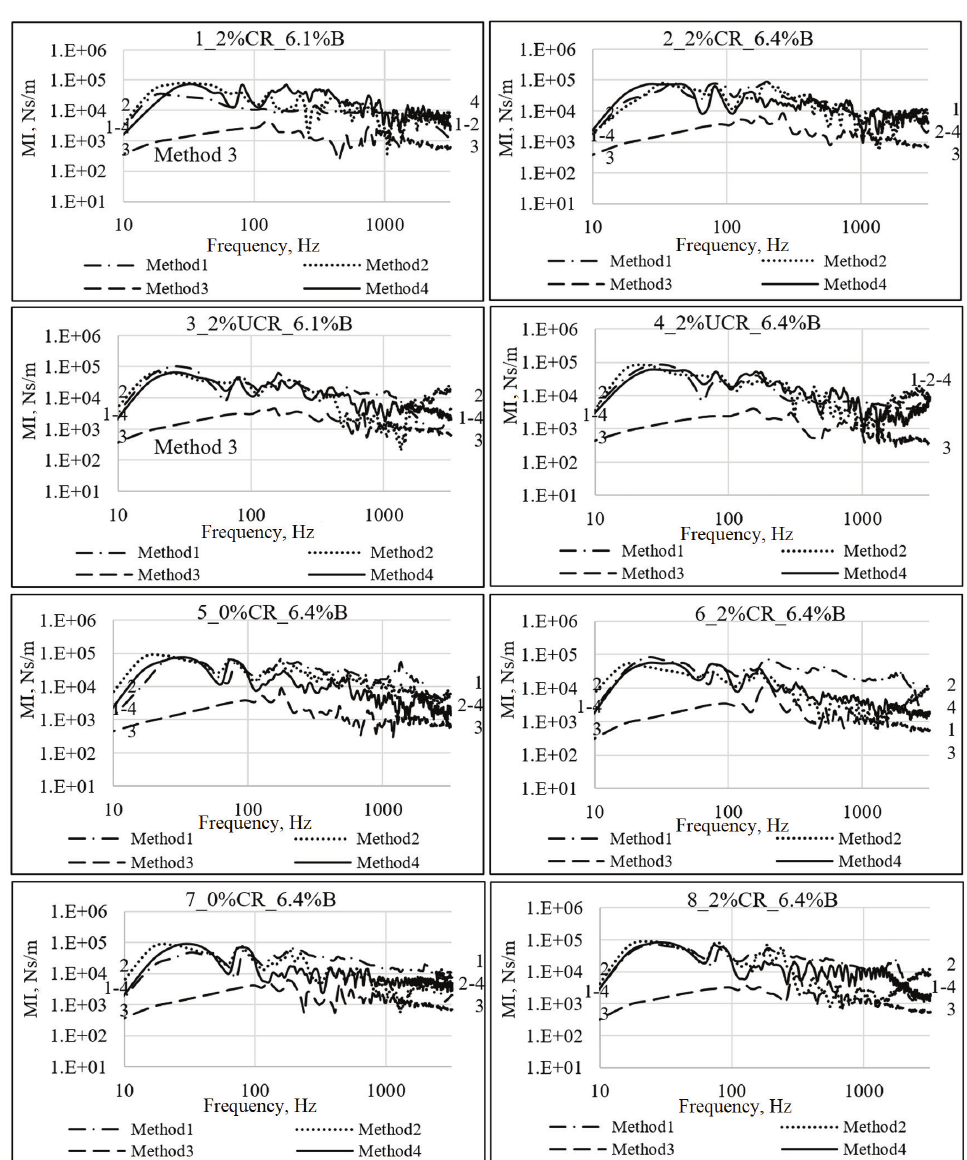
Figure 9. Comparison of Mechanical Impedance considering the four methods